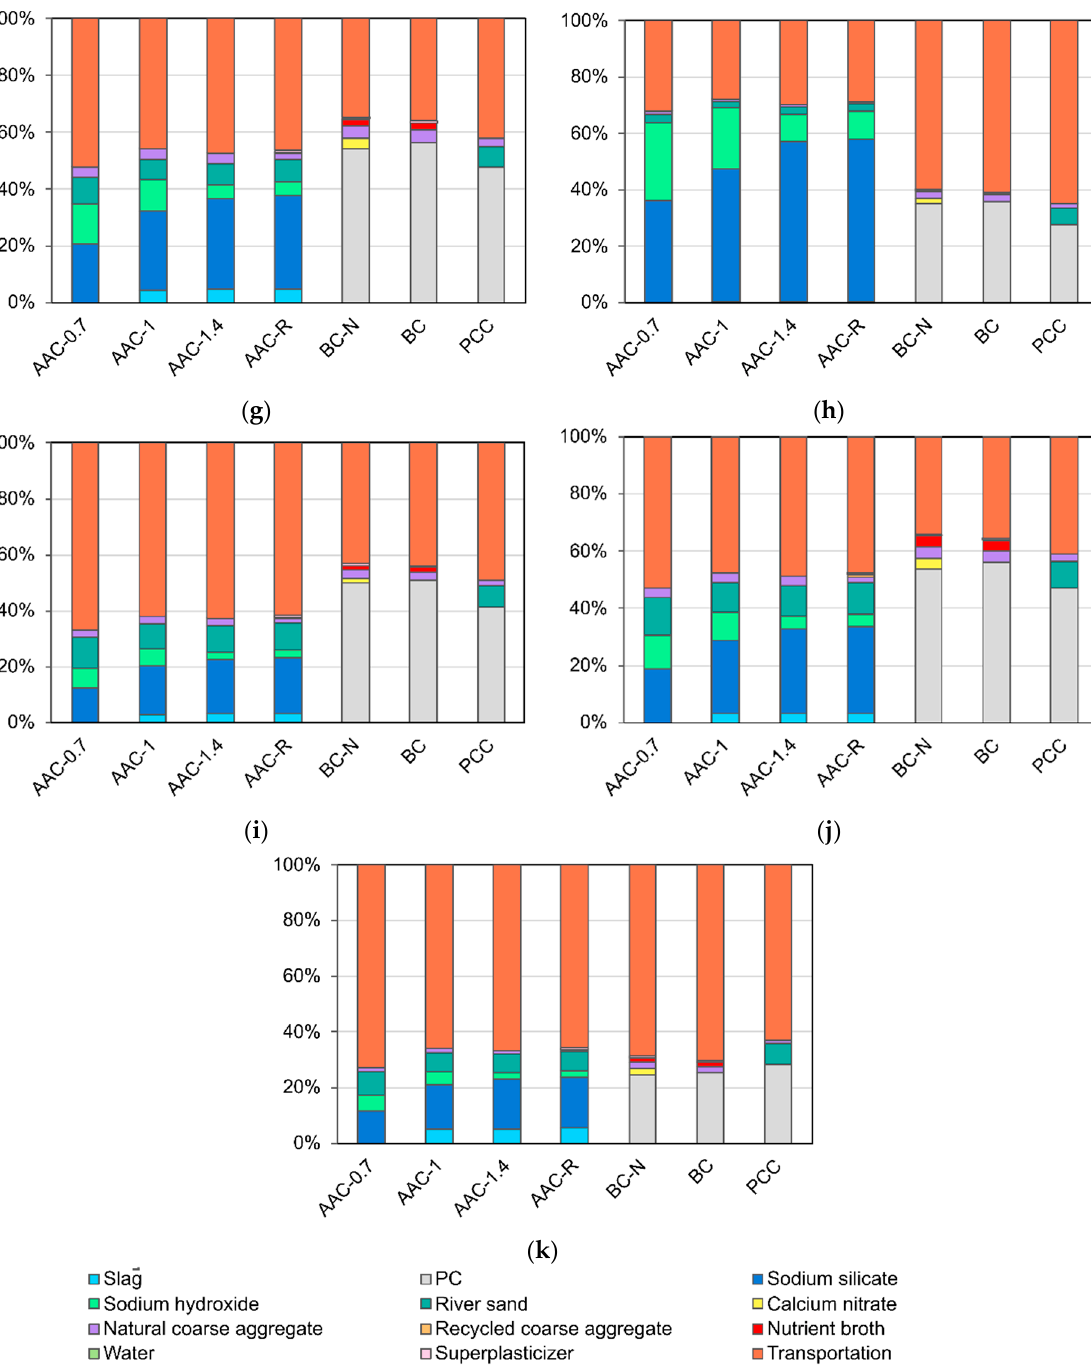
Figure 5. Environmental impacts (%) of different concrete mixes on midpoint damage categories: ( a ) Climate change, ( b ) Fossil depletion, ( c ) Freshwater ecotoxicity, ( d ) Freshwater eutrophication, ( e ) Human toxicity, ( f ) Marine ecotoxicity, ( g ) Marine eutrophication, ( h ) Ozone depletion, ( i ) Photochemical oxidant formation, ( j ) Terrestrial acidification, and ( k ) Terrestrial ecotoxicity.